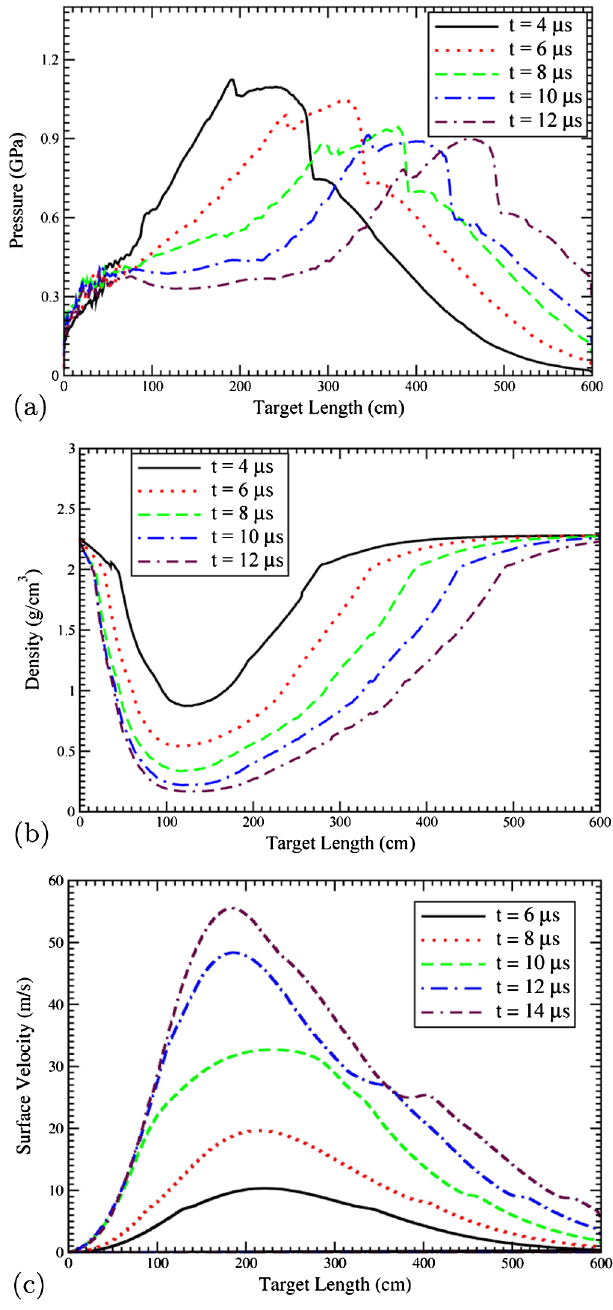
FIG. 9. (a) Pressure along the target axis at different times; (b) density along the target axis at different times; and (c) surface velocity along the target length at different